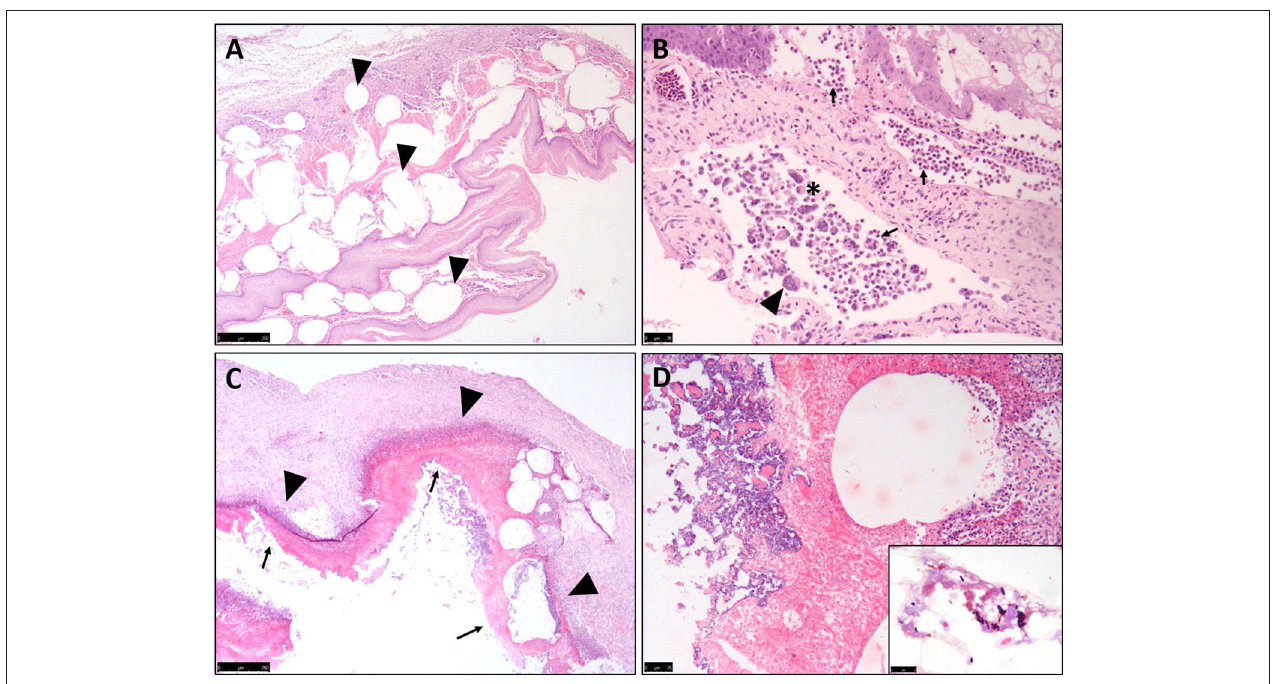
FIGURE 2 | Histopathological features of Nectarivorous Bird Emphysematous Ingluvitis (NBEI) in Loriinae Birds. (A–D) Representative photomicrographs of formalin-fixed section of crop. (A) Numerous sub-epithelial pseudo-cystic cavities (emphysema) [arrowheads] within the lamina propria, submucosa, muscularis mucosae and sub-adventitial layer (Case 9, H&E stain, Obj. 2 × ). (B) Multifocal to coalescing, moderate, mixed inflammatory infiltrations of mostly macrophages [asterix], heterophils [arrows] and occasional multinucleated giant cells (Langhans-type) [arrowheads] (Case 2, H&E stain, Obj. 20 × ). (C) Multifocal epithelial degeneration, sloughing and occasional mucosal ulceration superimposing inflammation [arrowheads] resulting in pseudomembrane formation [arrows] (Case 8, H&E stain, Obj. 4 × ) and (D) Multifocal mixed bacteria (Case 8, H&E stain, Obj. 40 × ) [Inset: Higher magnification of Gram-positive, slightly curved bacillary, Clostridium spp.-like bacteria (Case 8, Gram stain, Obj. 100 ×